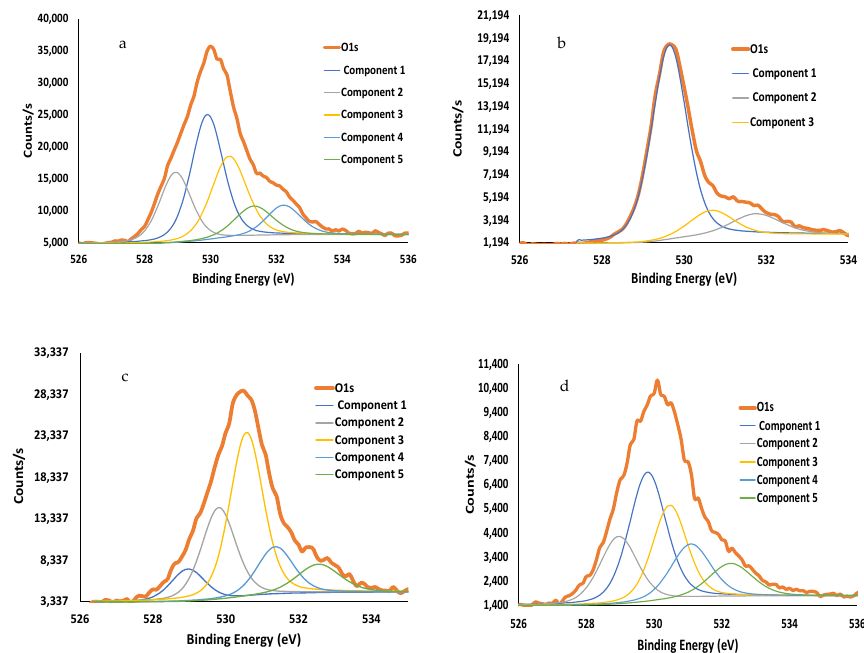
Table 6. Oxygen species detected by XPS in as-prepared materials.